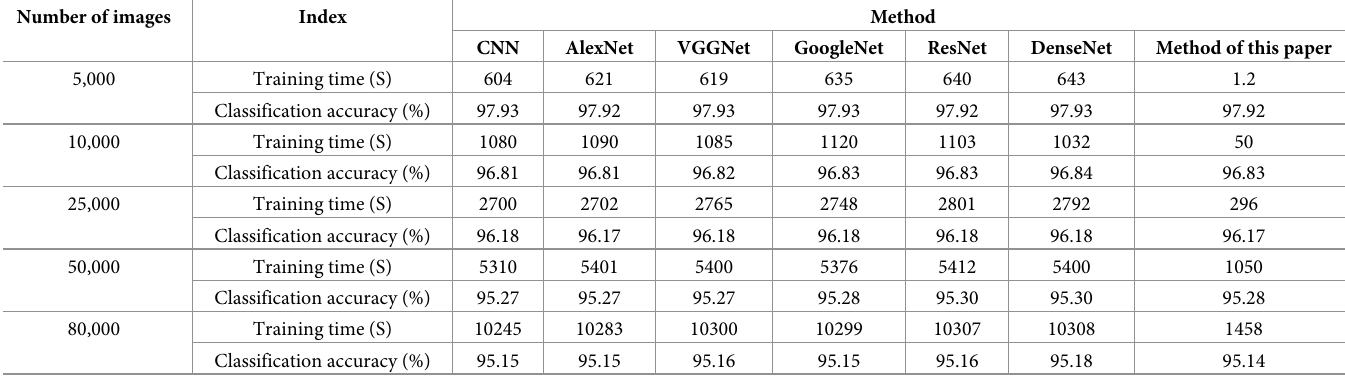
Table 2. Comprehensive comparison between the algorithm proposed in this paper and other deep learning